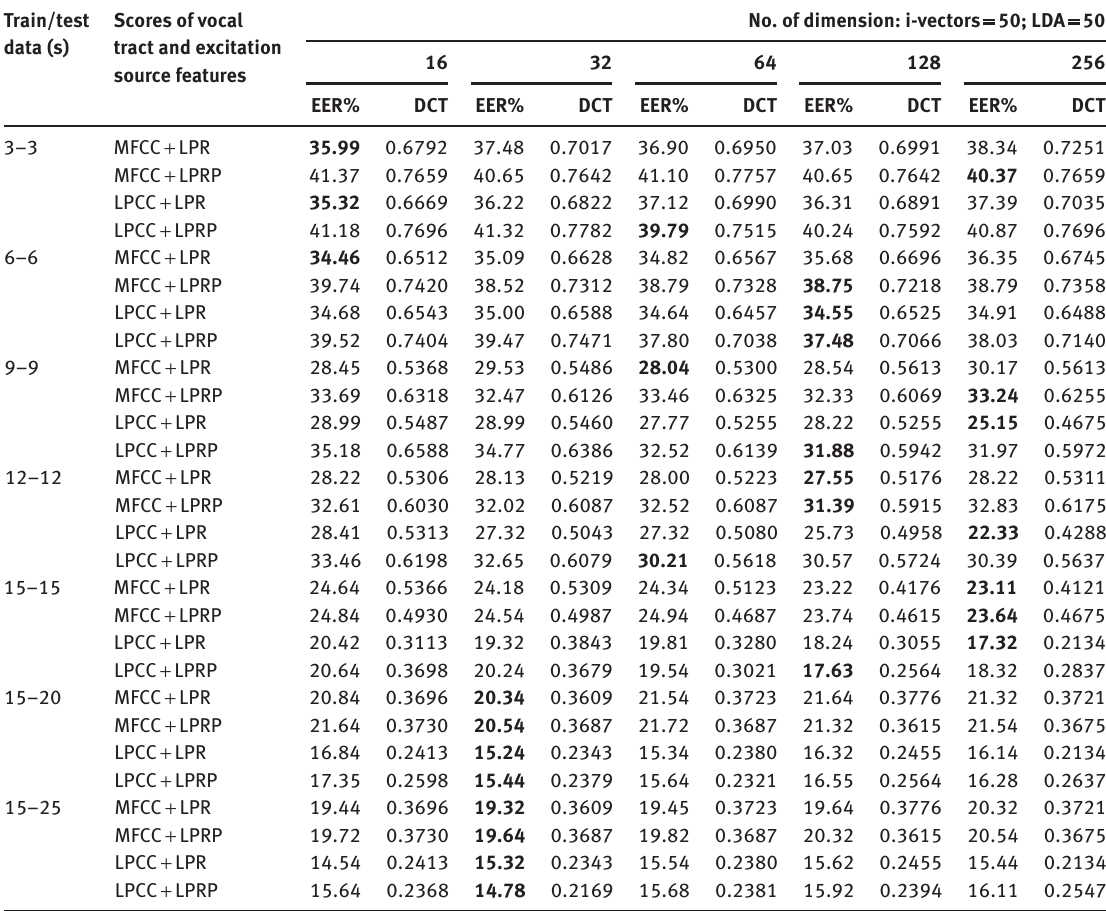
The bold values represent minimum EER of particular feature extraction techniques.